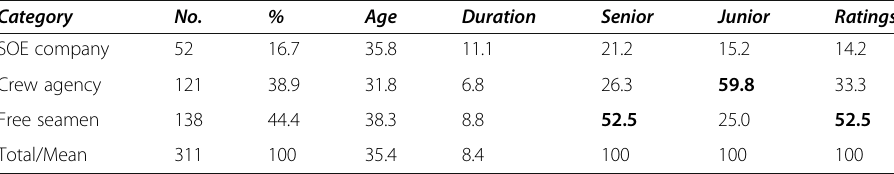
Table 2 Seafarers ’ age, duration and distribution by employment status and rank (years, %) Category No.